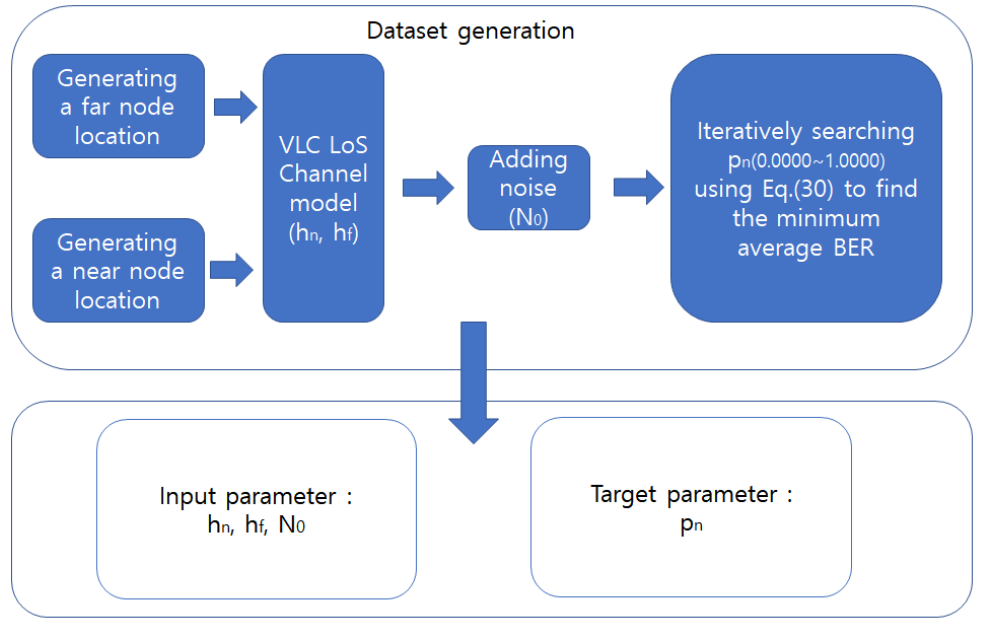
Figure 6. Dataset